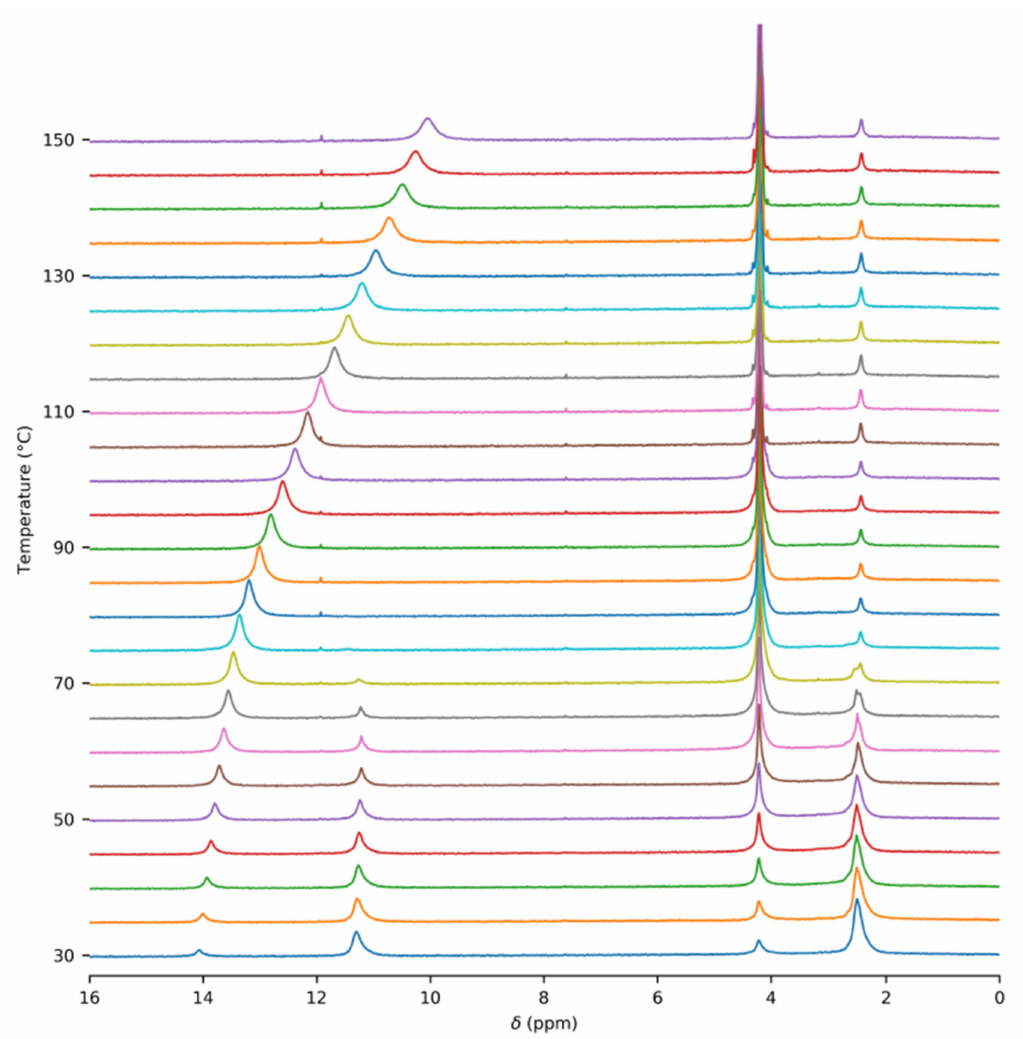
Figure 2. Temperature series of 1 H–NMR spectra of acetic acid (c = 7:9 mM) in the glass insert. The spectra were not referenced.